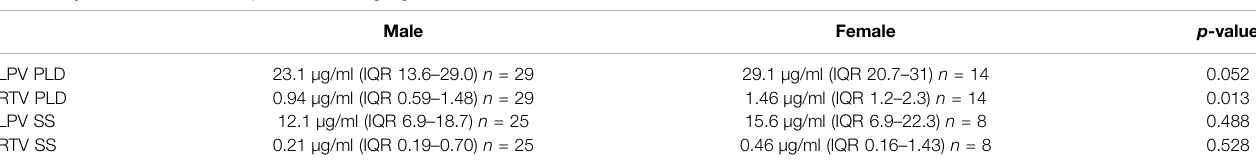
TABLE 4 | Gender differences of patients receiving high dose